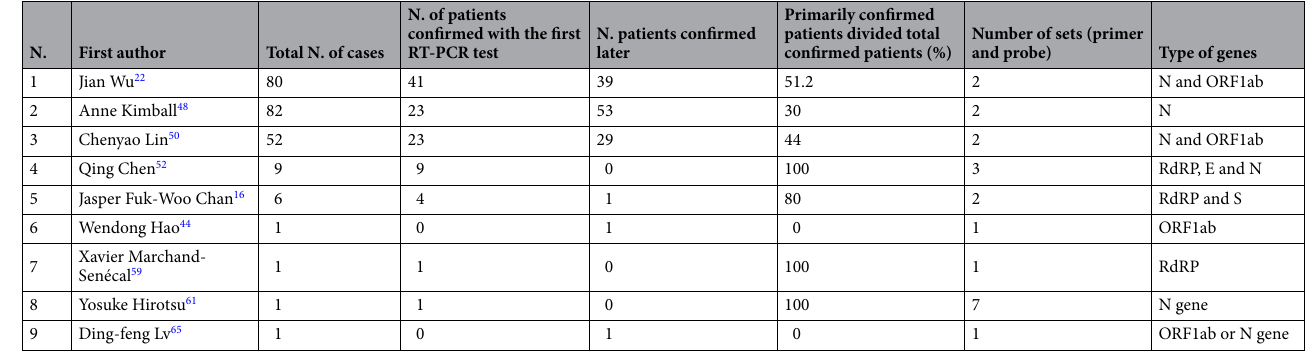
Table 3. From the information illustrated in Table 2, those which their primer and probe’s data were